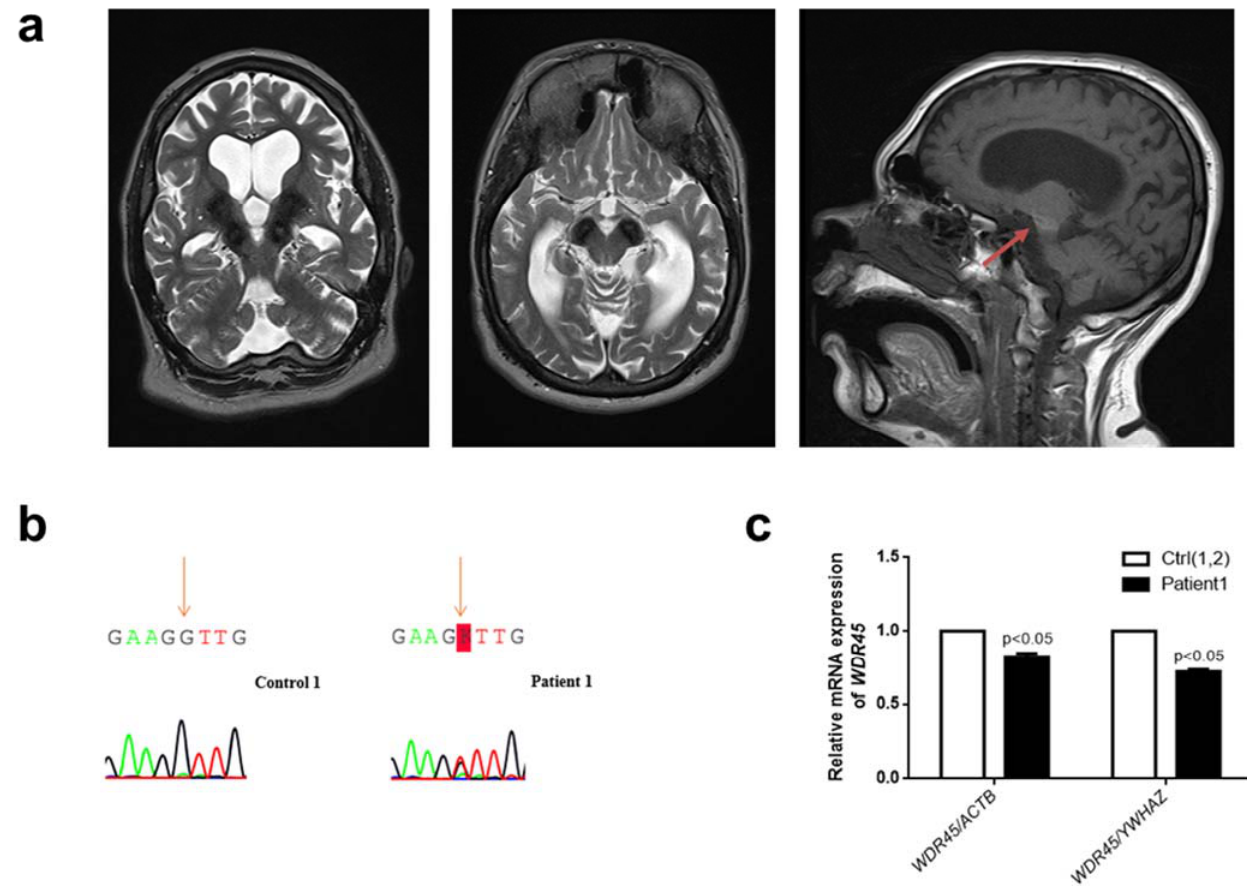
Figure 1. Clinical and genetic analysis of a novel female patient (Patient 1) with a missense WDR45 variant. ( a ) Brain MRI from Patient 1. The globus pallidus and the substantia nigra are extensively hy- pointense bilaterally on axial T2 sequences indicating high levels of iron deposition. The characteristic BPAN T1-hyperintense halo surrounding the substantia nigra is also noted (red arrow). ( b ) Electro- pherograms of Sanger sequencing of complementary DNA (cDNA) from cultured fibroblasts from Patient 1 (right panel) and a healthy individual (Control 1) (left panel) in the reverse direction. The variant is highlighted: “K” represents “G” or “T.” ( c ) The quantification of WDR45 mRNA levels in fibroblasts from Patient 1 compared to fibroblasts from two healthy individuals (Control 1 and Control 2—Ctrl(1,2)). Means and standard error of the mean (SEM) are indicated. Quantification is shown with the mean control level set as 1. The results are based on the mean ratios of WDR45 expression compared to two reference genes, ACTB and YWHAZ . Statistical significance was analyzed by one-way ANOVA ( p < 0.05 refers to a significant difference between Patient 1 and two healthy controls